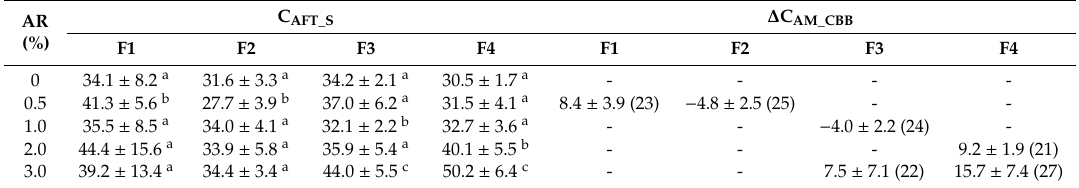
Di ff erent lower-case superscript letters in a column indicate significant di ff erences. ∆ C AM_CBB was calculated by using the same plus or minus sign figures between di ff erent lower-case superscript letters in a column. The number in parenthesis indicates the data number used for calculation. Table 6. Total soil nitrogen content in test fields following soil amelioration (tha − 1 ) and changes in soil